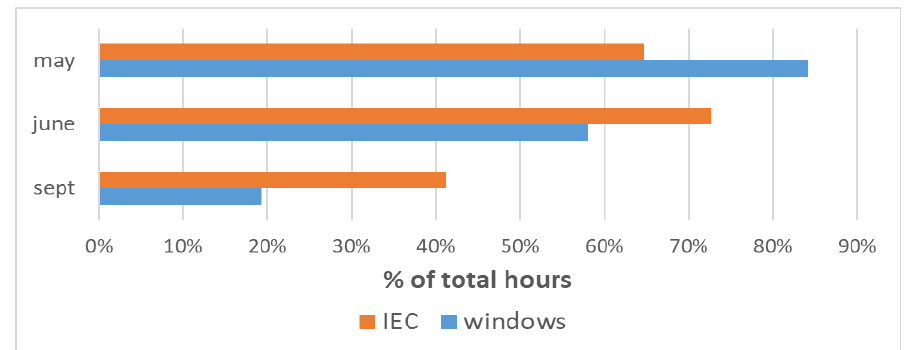
Figure 10. Percentage of hours of operation of windows by night and indirect evaporative cooling (IEC) by day from May to September 2017.